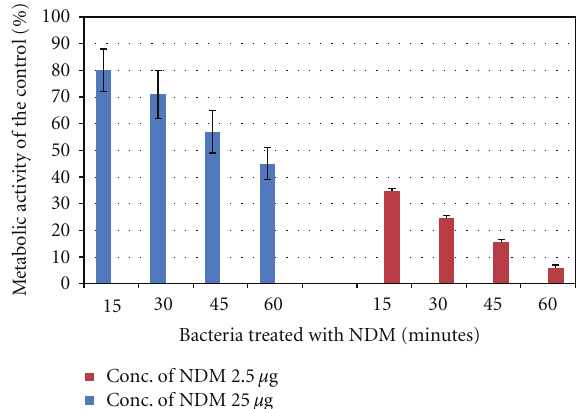
Figure 1: E ff ect of NDM treatment of bacteria on their metabolic activity determined by XTT assay.